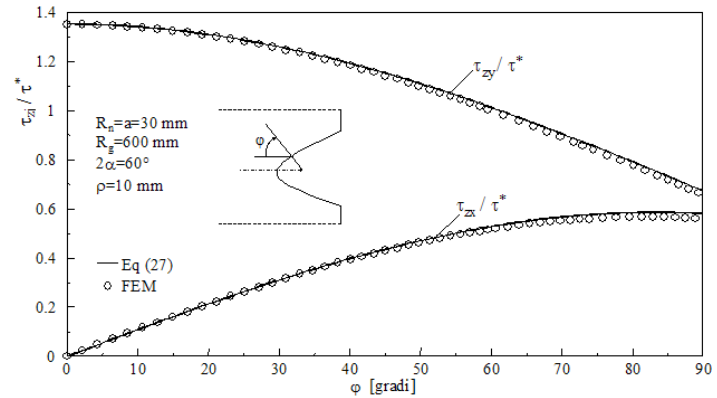
Figura 8: Campi di tensione lungo il bordo dell’intaglio normalizzati rispetto alla tensione nominale sulla sezione